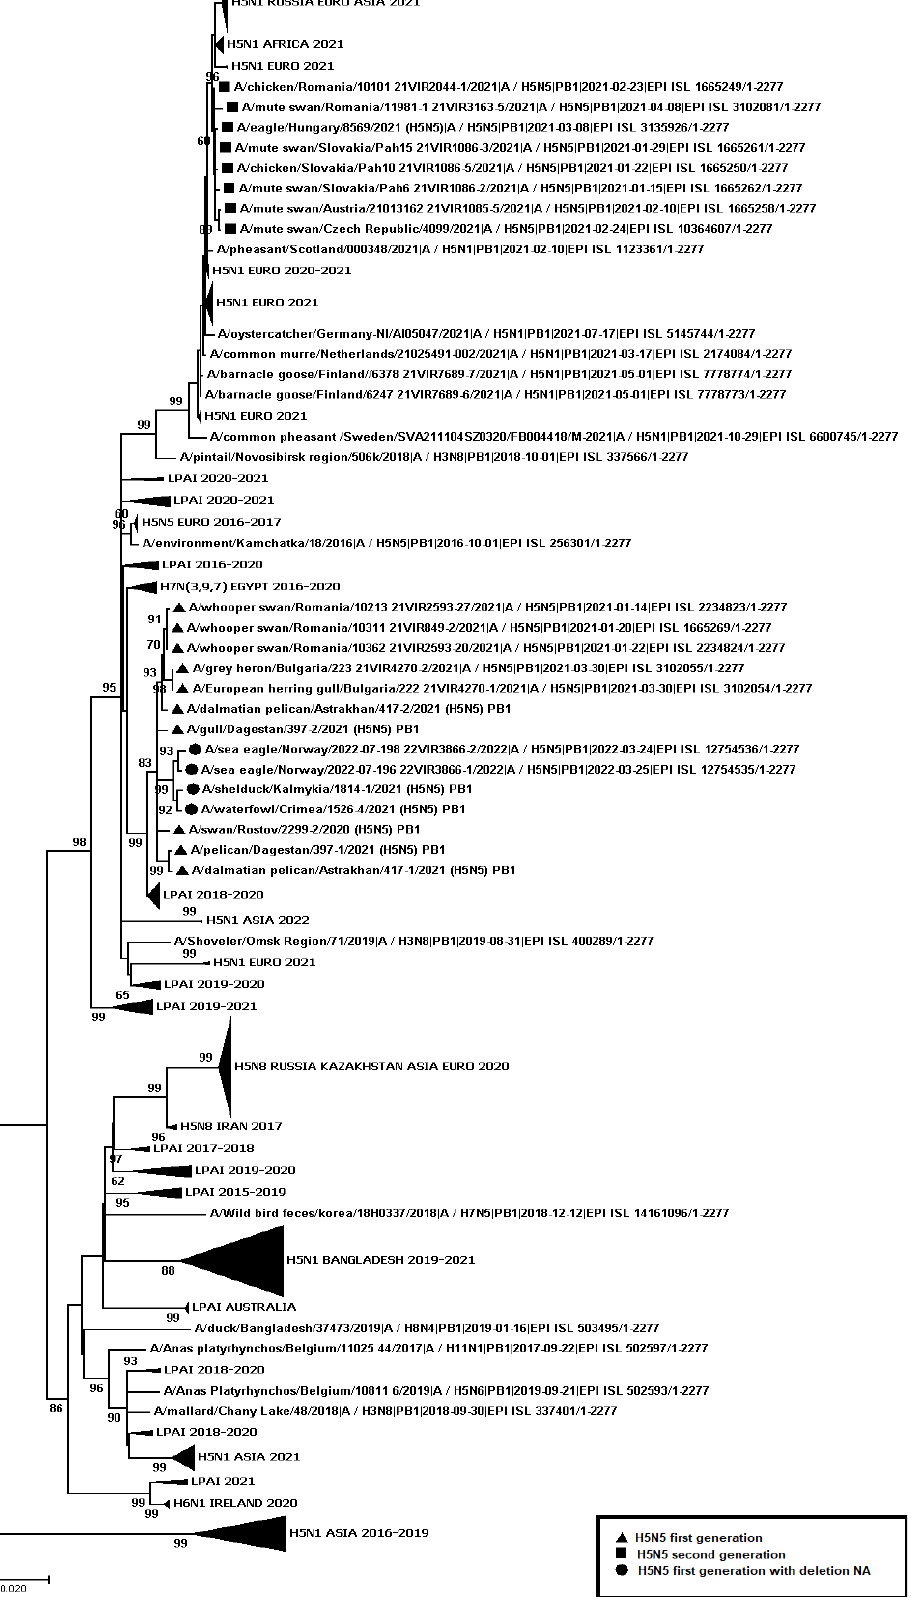
Figure 7. Phylogenetic tree constructed using the NJ method, based on the nucleotide sequence of the PB1 gene fragment (1–2275 bp ORF) of AIV subtype H5.